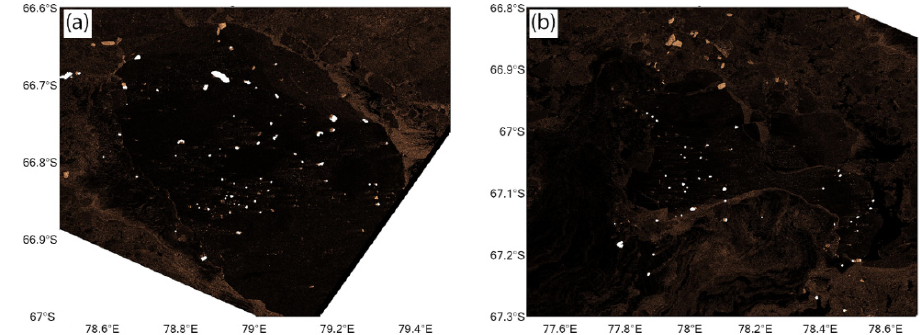
Figure 8. Small icebergs inside the fast ice in the eastern part of the FLBP. ( a ) Northern fast ice in Figure 7c, and ( b ) southern fast ice in Figure 7c. The small icebergs that never moved during the five-month-long period in 2010 are shown as white pixels. The dark area surrounding the small white icebergs is the fast ice. The background image is an ASAR IMS image taken on 15 October 2010.